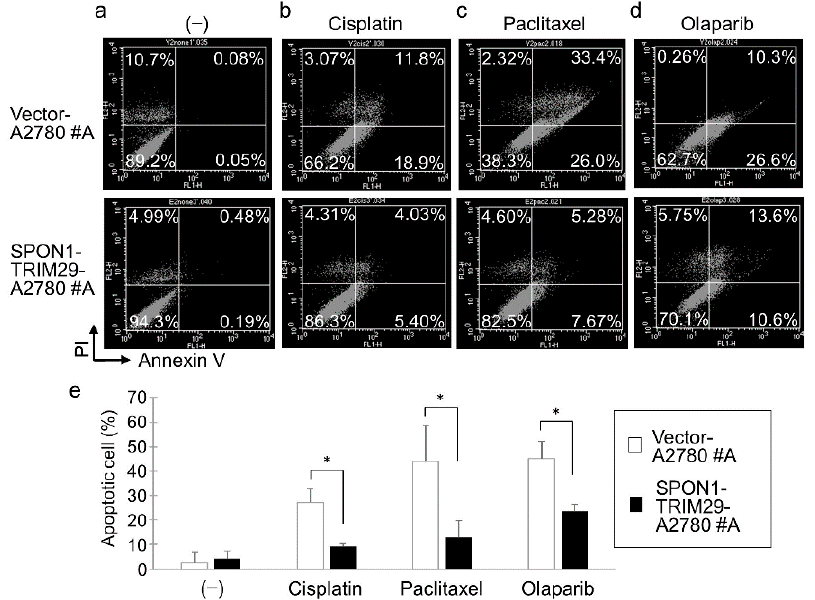
Figure 3. SPON1-TRIM29 expression inhibits cancer drug-induced apoptosis in ovarian cancer cells. ( a – d ) Vector-A2780 #A and SPON1-TRIM29-A2780 #A cells were seeded in 6 cm-dish on day 0. Either vehicle ( − ) ( a ), 1 µ M cisplatin ( b ), 5 nM paclitaxel ( c ), or 2 µ M olaparib ( d ) was added into the